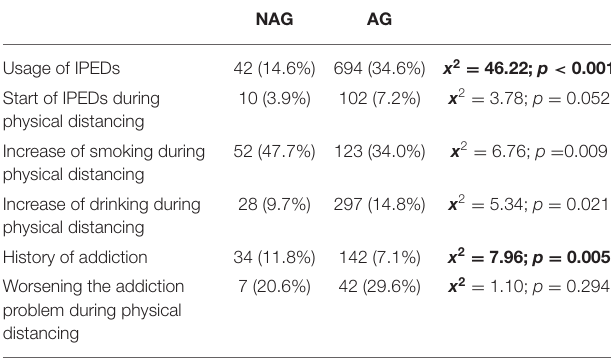
TABLE 3 | Differences in IPEDs use and behavioral changes between AG and